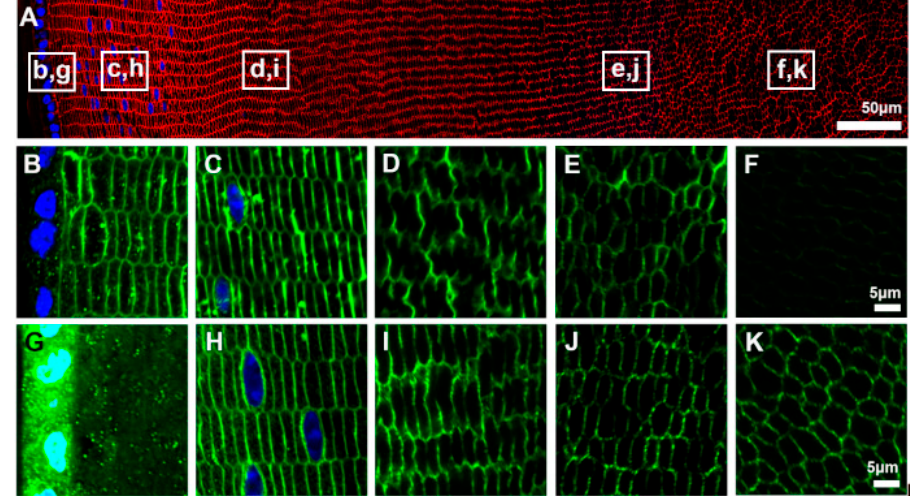
Figure 2. Comparison of the subcellular expression patterns of AQP0 and AQP5 in the rat lenses. ( A ) An equatorial section of a 6-week-old rat lens labeled with the membrane marker WGA (red) and the nuclear stain DAPI (blue) showing the regions (white boxes) from which high magnification images of the subcellular location of AQP0 ( b – f ) and AQP5 ( g – k ) were obtained; ( B – F ) AQP0 (green) is expressed in the membrane of both differentiating fiber cells and mature fiber cells but the antibody labelling is lost in the lens core ( F ) due to truncation of the C-terminal tail of AQP0 which contains the antibody epitope; ( G – K ) AQP5 labelling is associated with the membranes of fiber cells throughout the majority of the lens except for a region in the lens periphery where it is found as a pool of cytoplasmic labelling ( G ) before it translocates exclusively to the membranes of differentiating fiber cells ( H ).